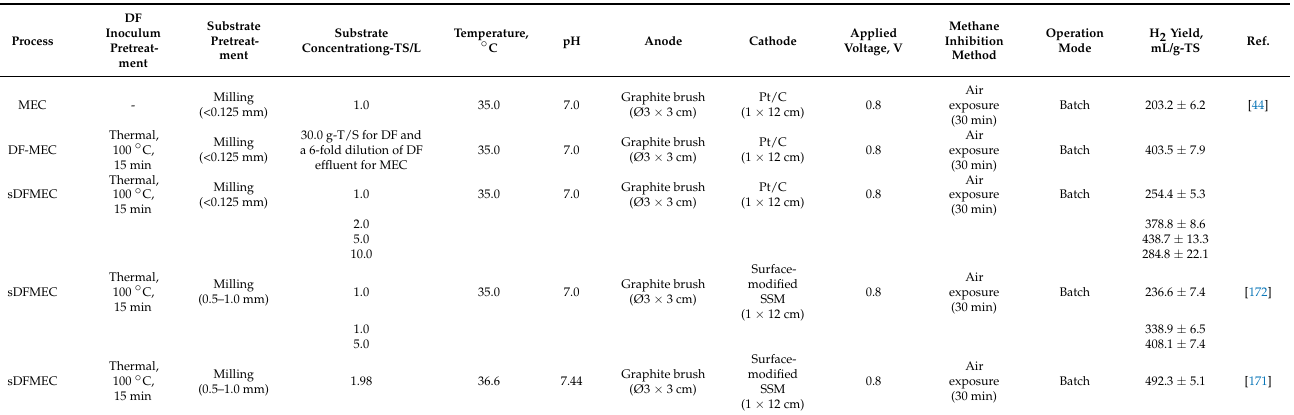
Table 4. Summarization of biohydrogen production from S. japonica via MEC and its combination with DF.